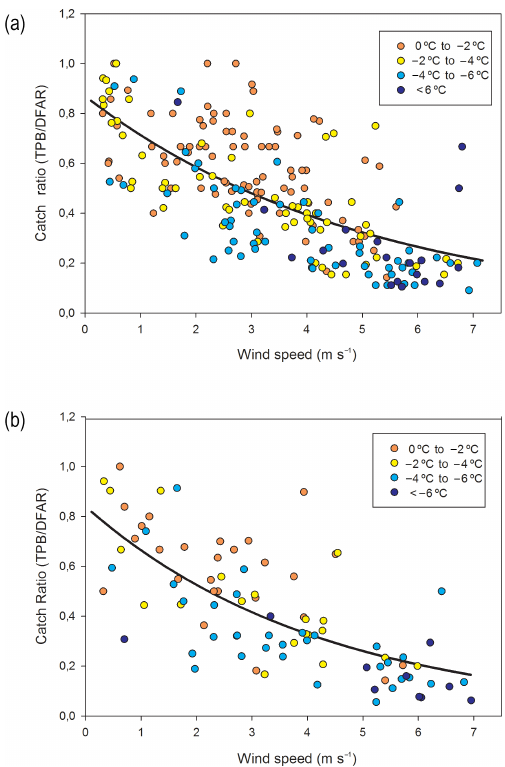
Figure 6. The relationship between catch ratio (TPB/DFAR) and wind speed for accumulation periods of (a) 1 and (b) 3h. The mean temperature during each accumulation period is indicated by colour.